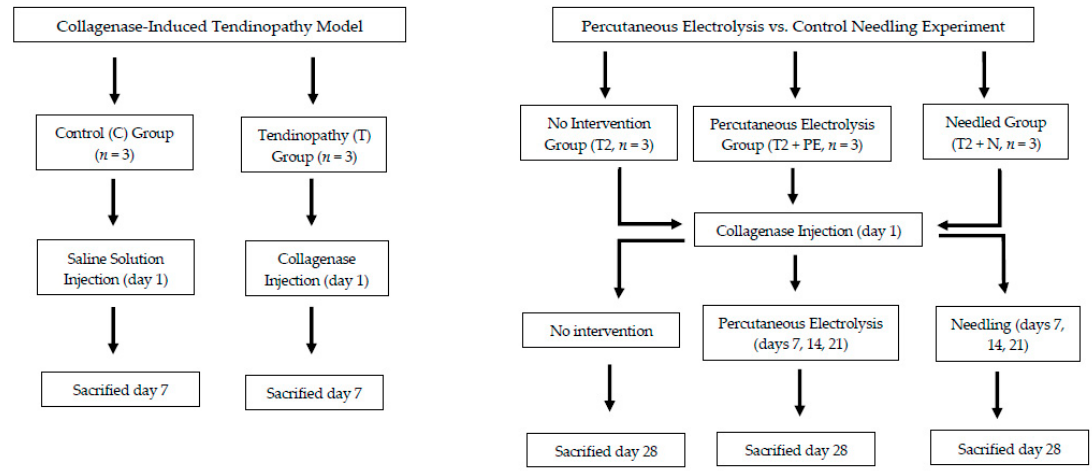
Figure 2. Flow Diagram summarizing the Experiment Groups.